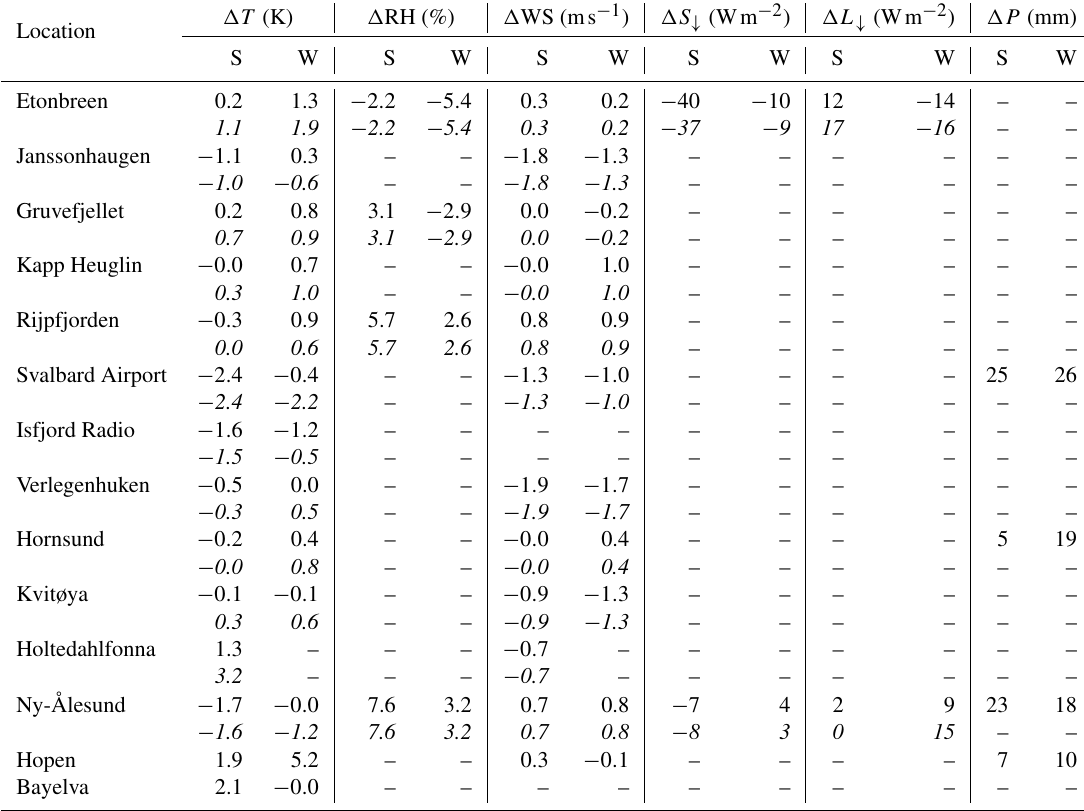
Table 2. Seasonal biases in meteorological variables (downscaled minus observational averages) at all observation sites averaged over each site’s observation period (Table 1). Shown are air temperature T , relative humidity, RH, wind speed, WS, shortwave radiation, S ↓ , longwave radiation, L ↓ and precipitation, P . Column headings S and W denote summer (June–August) and winter (September–May) respectively. Positive numbers indicate that the model results are larger than the observations. The second row at each site (italicized font) shows the bias between the downscaled and corresponding coarse ERA